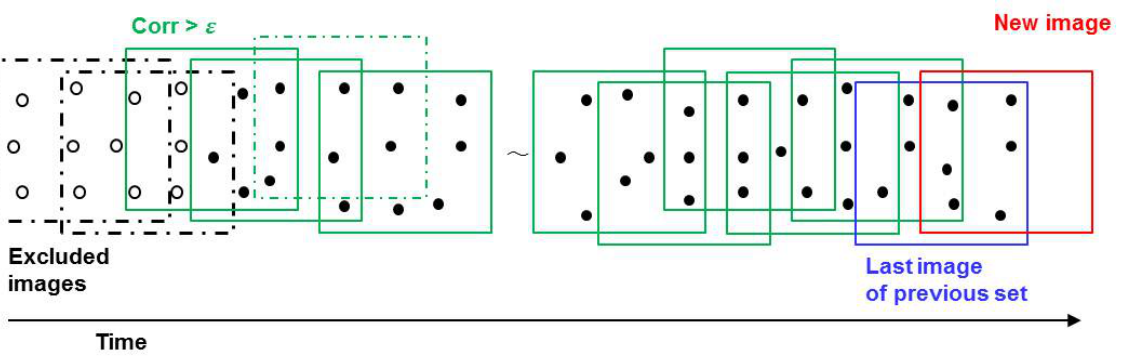
Figure 2. Exclusion process of the previous